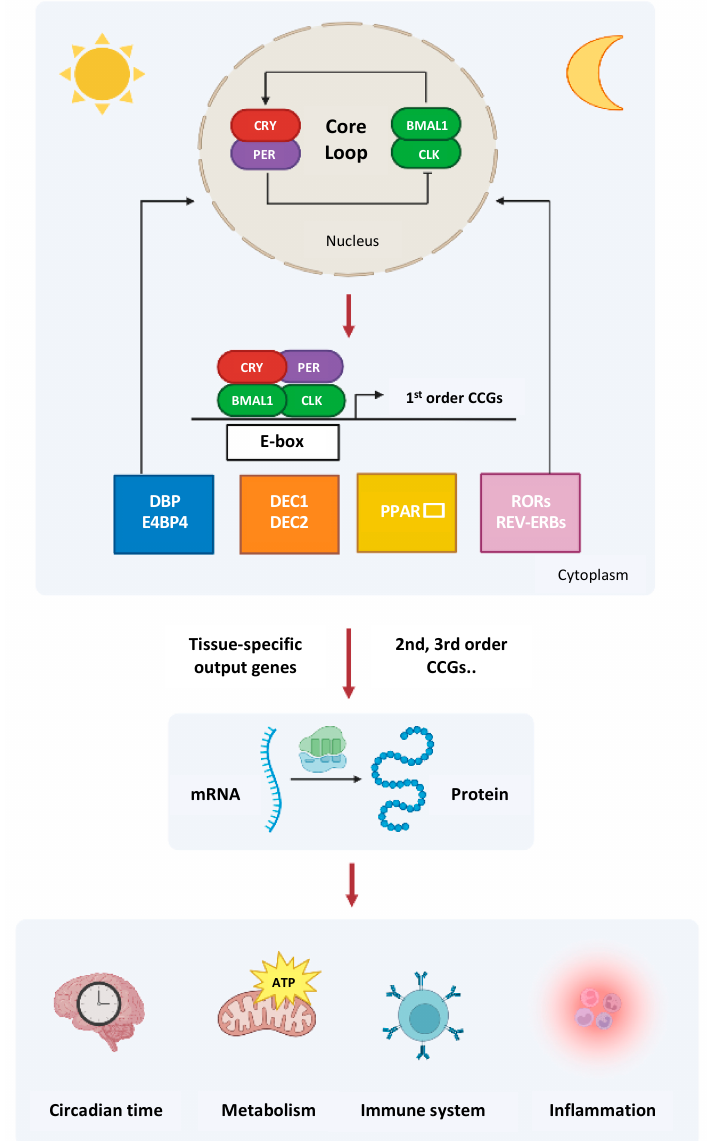
Figure 1. Schematic representation of the molecular clockwork driving the expression of thousands of downstream genes through transcription factors encoded by first order clock-controlled genes (CCGs). The second and third order specific output genes manage cell processes and tissue functions crucial for body homeostasis along with chronotype and taking part in ageing-related derangements.